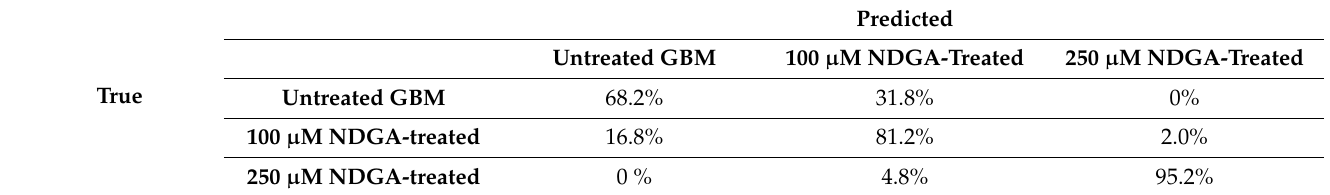
Table 2. Classification accuracy using 5-fold cross validation